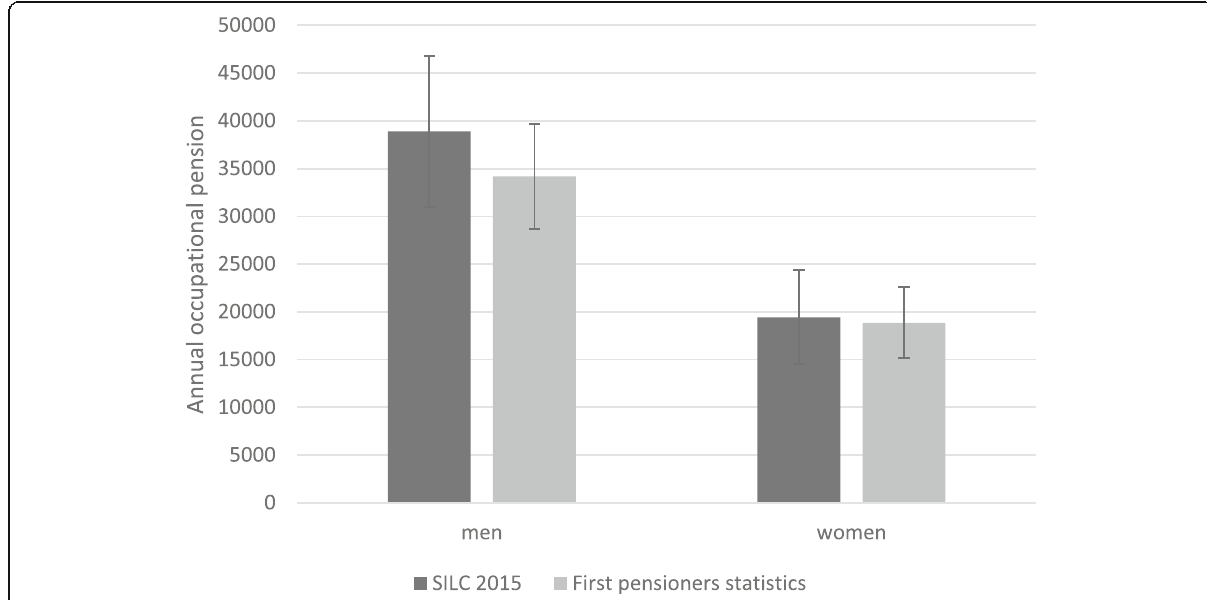
Fig. 2 Accuracy of second pillar pension wealth of retired individuals Note: mean values. SILC sample: individuals who reached regular retirement age in 2014 and received an occupational pension, survey weights applied. New pension statistics: individuals before or at regular retirement age who received their first pension in 2015 ( n = 22,543 men; 13,207 women), weighted average. Source: CH-SILC 2015 (own calculation) and SFSO